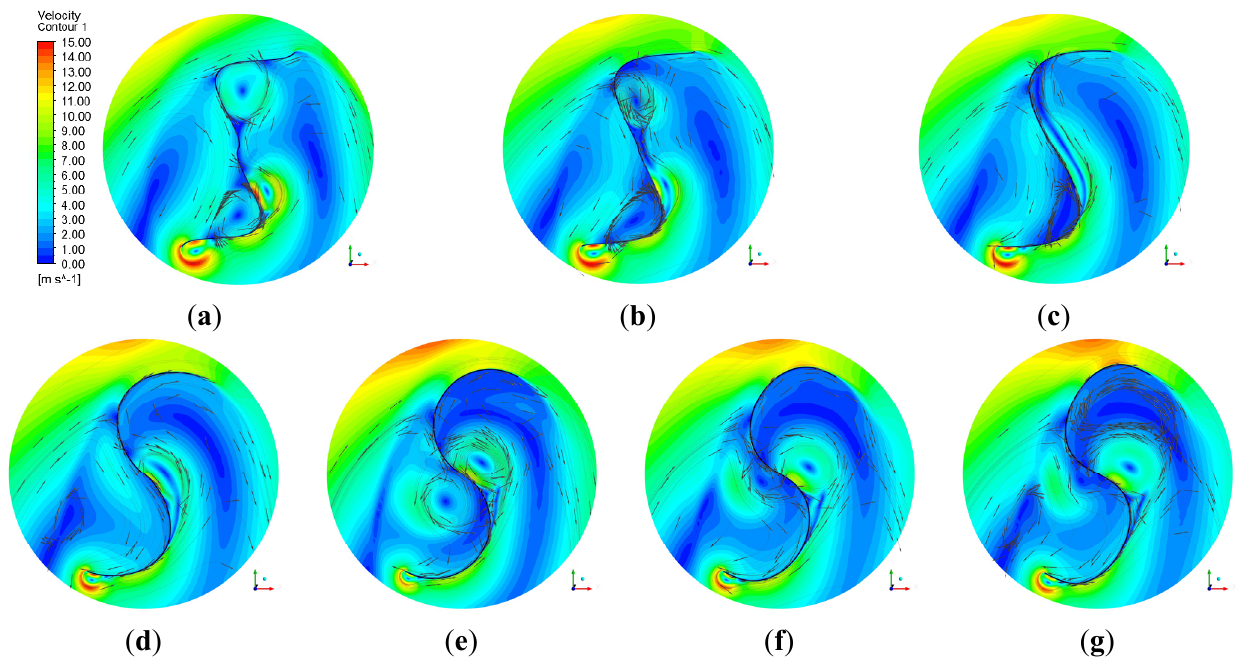
Figure 12. Velocity contours (m/s) and streamlines near the turbine for λ = 0.8 and θ = 60°. ( a ) n = 0.5; ( b ) n = 0.75; ( c ) n = 1.0; ( d ) n = 1.5; ( e ) n = 2.0; ( f ) n = 2.5; and ( g ) n =